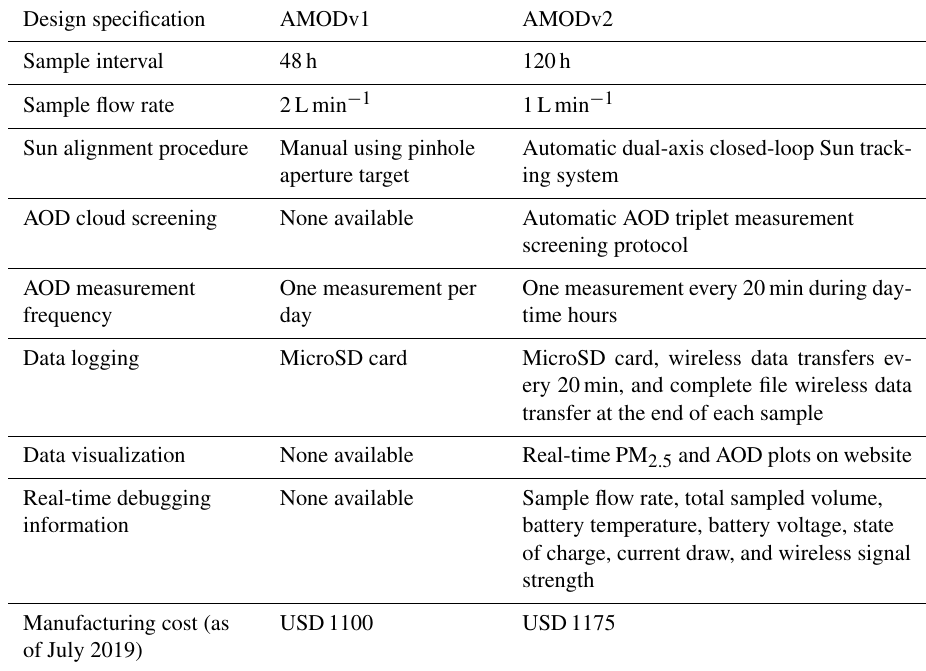
Table 1. Design comparison between AMODv1 and AMODv2.